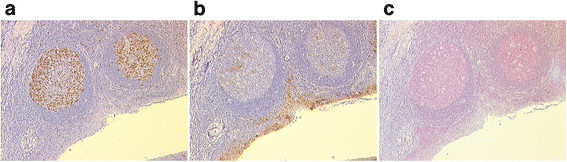
Immunohistochemical staining ofCyclin A1(a),p16(b) andp53(c) in a benign tonsil. Tonsil of a 41 year old man; HPV16 negative; Cyclin A1 overexpression (category 4); P16 category 2; P53 category 2; original magnification: x50